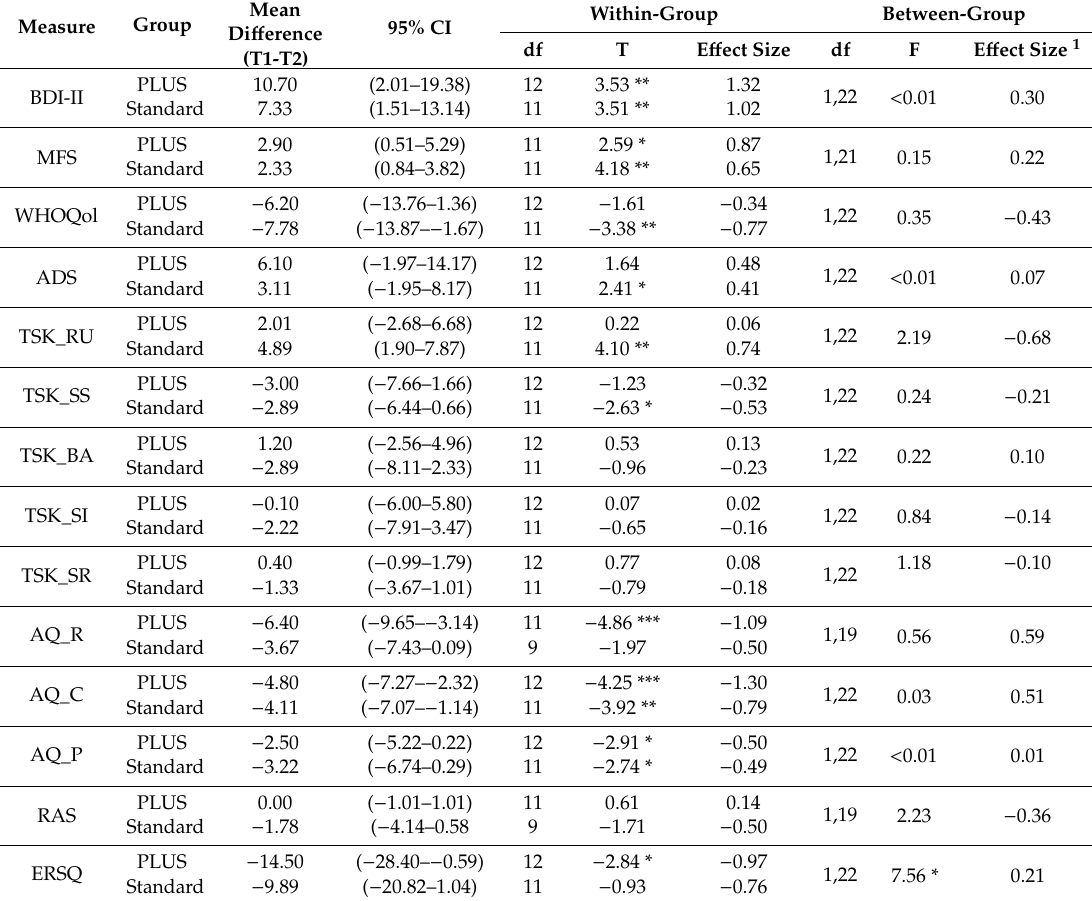
Table 4. Results of analyses of covariance at post-treatment (T2) controlled for baseline (T1) and within- and between-group e ff ect sizes at